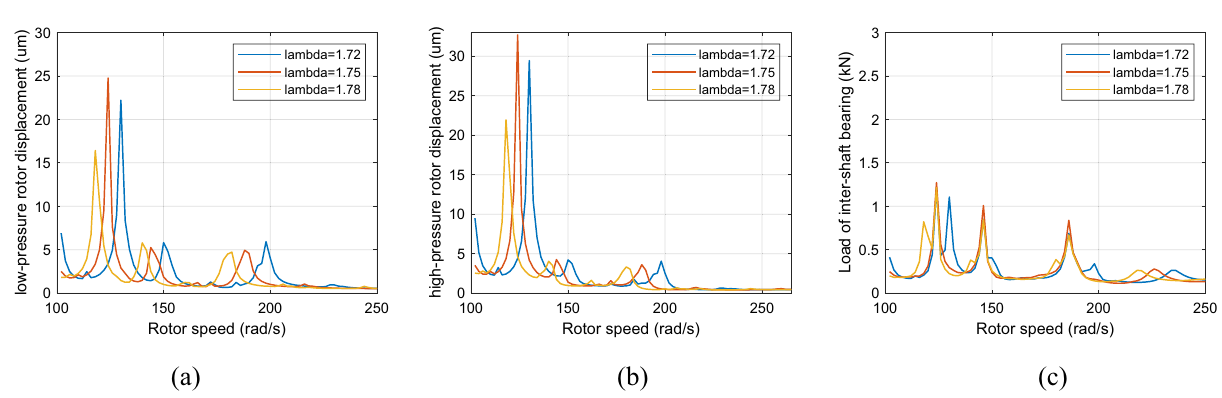
Figure 10. Partial enlarged view of Fig. 8 (λ = 1. 72, 1. 75, 1. 78, F 0 = 0, A max = 200) ( a ) LP rotor ( b ) HP rotor ( c ) inter-shaft bearing’s load.